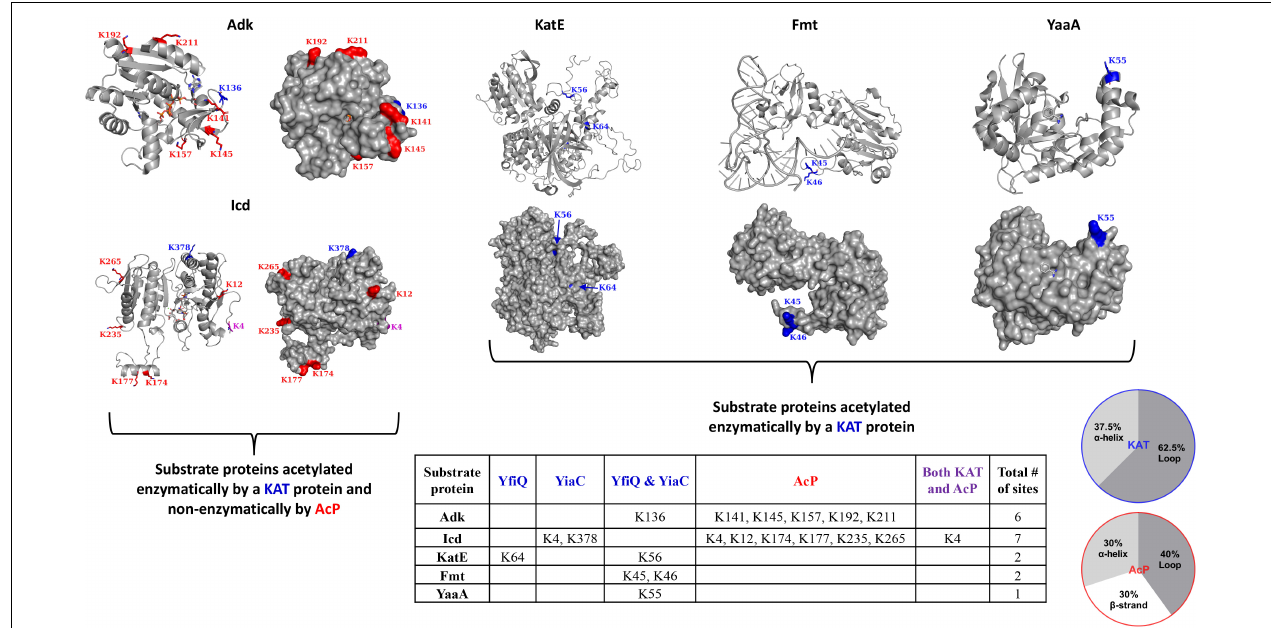
FIGURE 2 | Escherichia coli K-12 lysine acetyltransferase (KAT) and acetyl phosphate (AcP) acetylation sites on substrate proteins Adk, Icd, KatE, Fmt, and YaaA. The table details sites of acetylation that occur via KATs (blue) YfiQ, YiaC, or both YfiQ and YiaC, AcP (red), or both KATs and AcP (purple). The crystal structures of the substrate proteins are in gray ribbons and the lysine residues that were previously identified as acetylated in E. coli K-12 are shown with sticks and colored by type of acetylation. AcP acetylation sites are in red, KAT acetylation sites are in blue, and both AcP and KAT acetylation sites are in purple. Monomers from the crystal structures are the same as those described in Figure 1 and Adk is shown in the closed conformation. The pie charts show the percentage of KAT and AcP sites on Adk, Icd, Fmt, KatE, and YaaA E. coli proteins that are located on alpha helices, beta strands, or